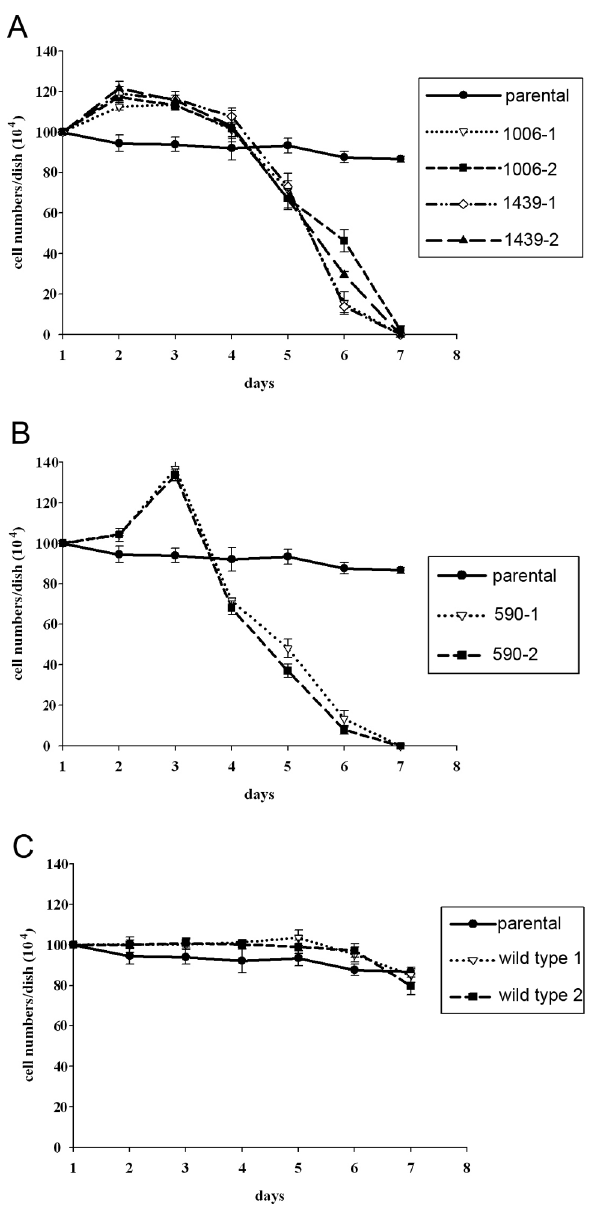
Figure 5. Effect of nutrient starvation on the cells expressing mutant SWAP-70 s. 1 6 10 6 cells were plated onto 6-cm plates, and cell number was counted every day. Medium was not changed during the experiments. For reference, the growth curves of the parental cells are shown in every graph.